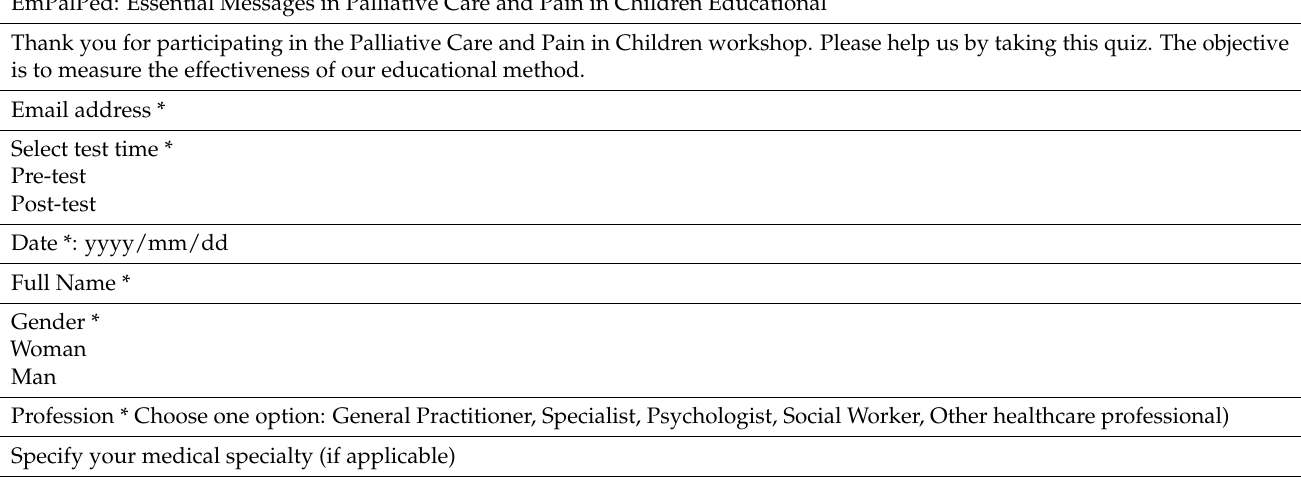
Table A3. Pre and Post test: EmPalPed